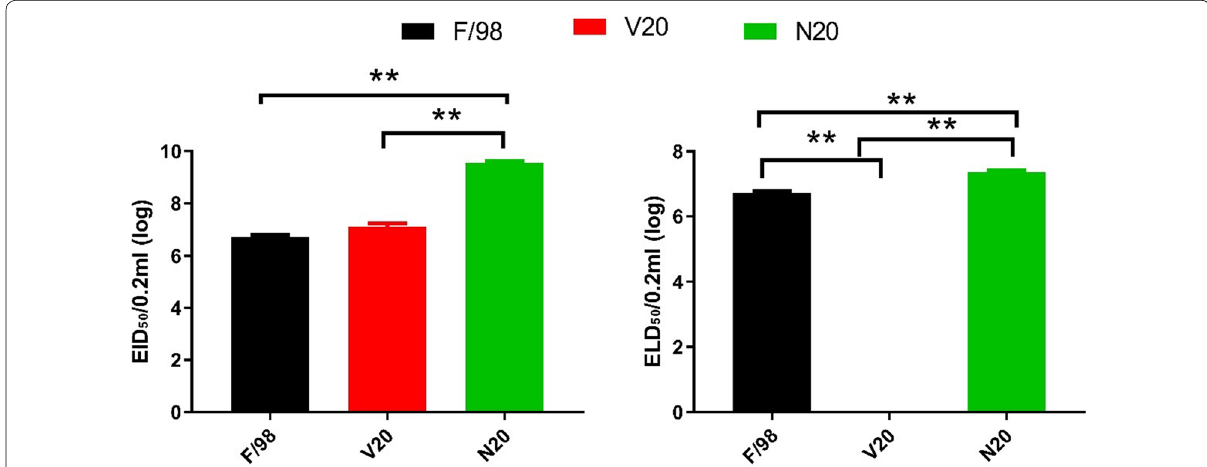
Fig. 7 EID 50 and ELD 50 of the progeny strains. **, significant difference, P <